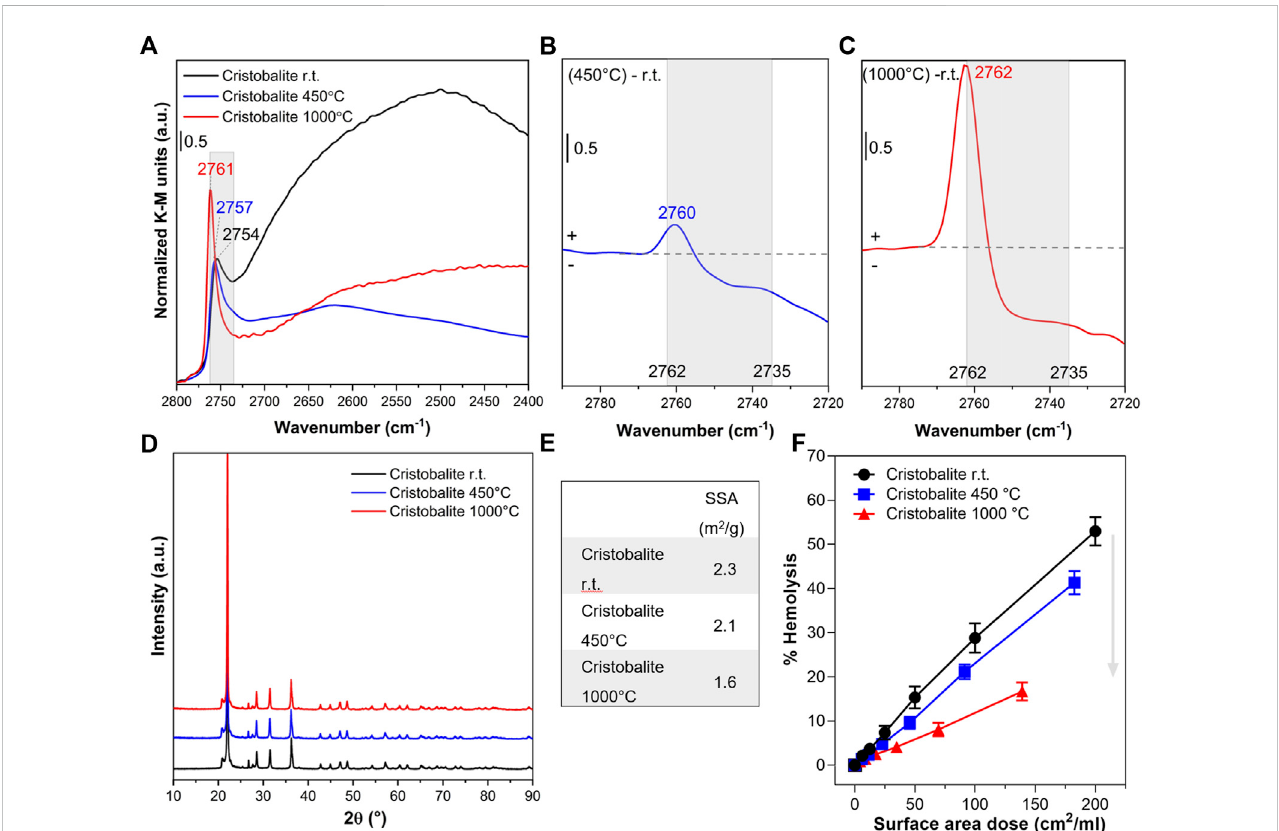
FIGURE 3 Nearly free silanols (NFS) determine the membranolytic activity of cristobalite. Pristine cristobalite particles (i.e., room temperature, r.t.) were calcined at 450 ° and 1,000 ° C. (A) Surface silanol distribution measured by DRIFTspectroscopy after H/D exchange in the ν OD spectral region. (B,C) Differences in silanol populationbetweencristobalitecalcinedat450 ° Candpristine (B) orcristobalitecalcinedat1,000 ° Candpristine (C) .Spectraarecenteredtothe ν ODspectral regionassignedtoNFS(2,760 – 2,735 cm − 1 )andisolatedsilanols. (D) XRPDpatterns. (E) Speci fi csurfaceareaevaluatedbyBETmethodwithKradsorption. (F) Membranolytic activity (percent hemolysis) of particles that were incubated for 30 min with puri fi ed sheep RBCs. Data are reported per surface area dose and are mean ± SEM of three independent